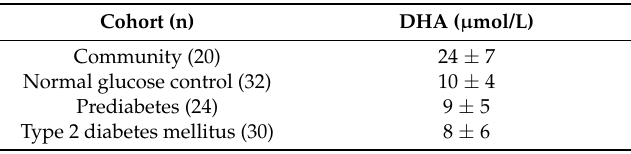
Table 2. DHA concentrations in stored plasma samples 1 .